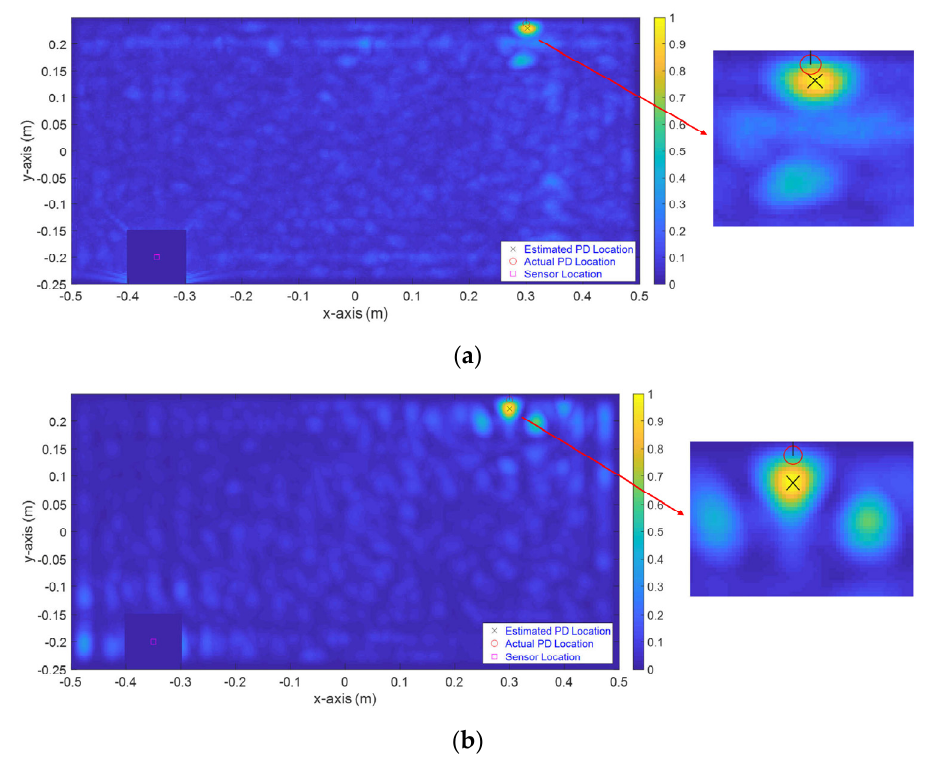
Figure 6. The distribution of normalized maximum electric field power over the complete simulation time interval on the computational domain, ( a ) obtained by the EMIF method with a 10.3 mm localization error and ( b ) obtained by the EMTR method with a 17.5 mm localization